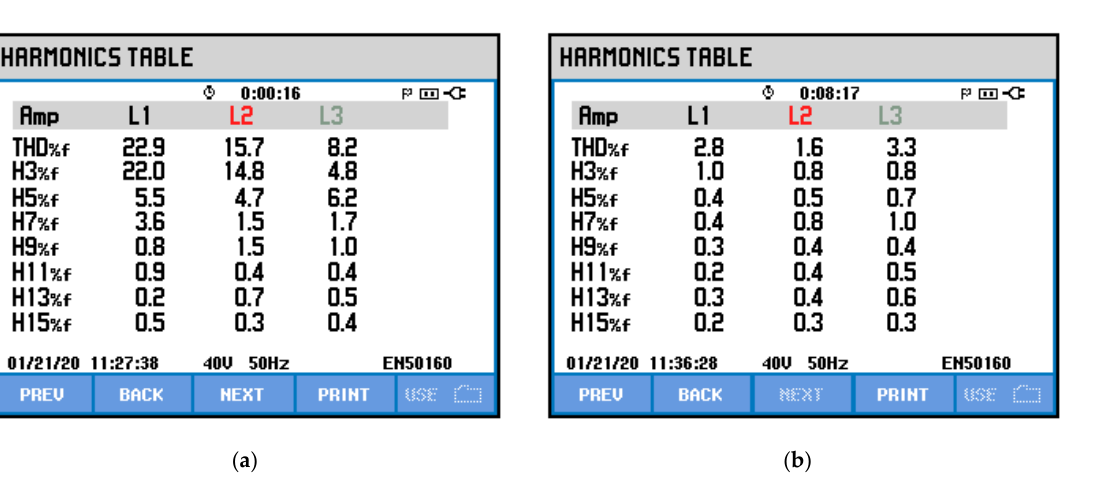
Figure 21. Harmonic contents value of the three-phase currents at the secondary windings of the V/V transformer (when two load sections are loaded): ( a ) before compensation; ( b ) after compensation.